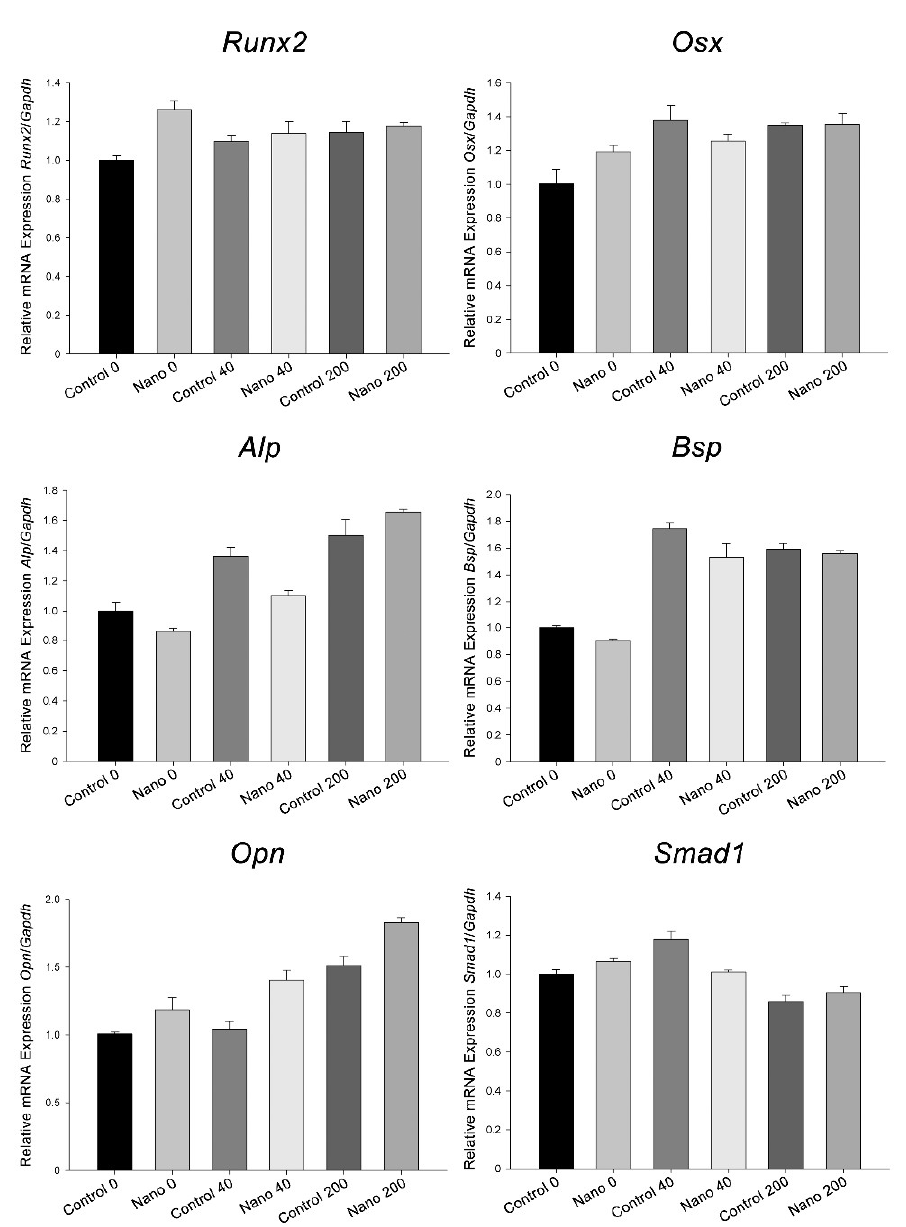
Figure 4. Runx2 , Osx , Alp , Bsp , Opn , and Smad1 mRNA expression levels normalized to Gapdh in MC3T3-E1 cell cultures grown on Control-Ti and Nano-Ti on day 5 of culture, exposed or not on days 2 and 4 of culture to 40 and 200 ng/mL BMP-7 in the culture medium. The bars represent one biological replicate (resulting from the pooling of 16 independent wells/experimental replicates for each group) run in three technical replicates (mean and SD). The mean value of the control group (Control 0) was assigned the value of